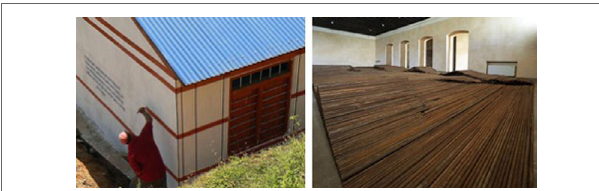
FigURe 1 | On the left: earthquake-resistant school built by the Smart Shelter Foundation in Nepal (courtesy of Smart Shelter Foundation); on the right: artwork “Straight” by the Chinese artist Ai Weiwei, Royal Academy (London, UK).